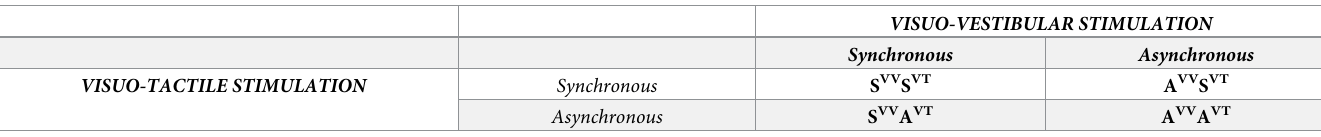
Table 1. 2x2 factorial